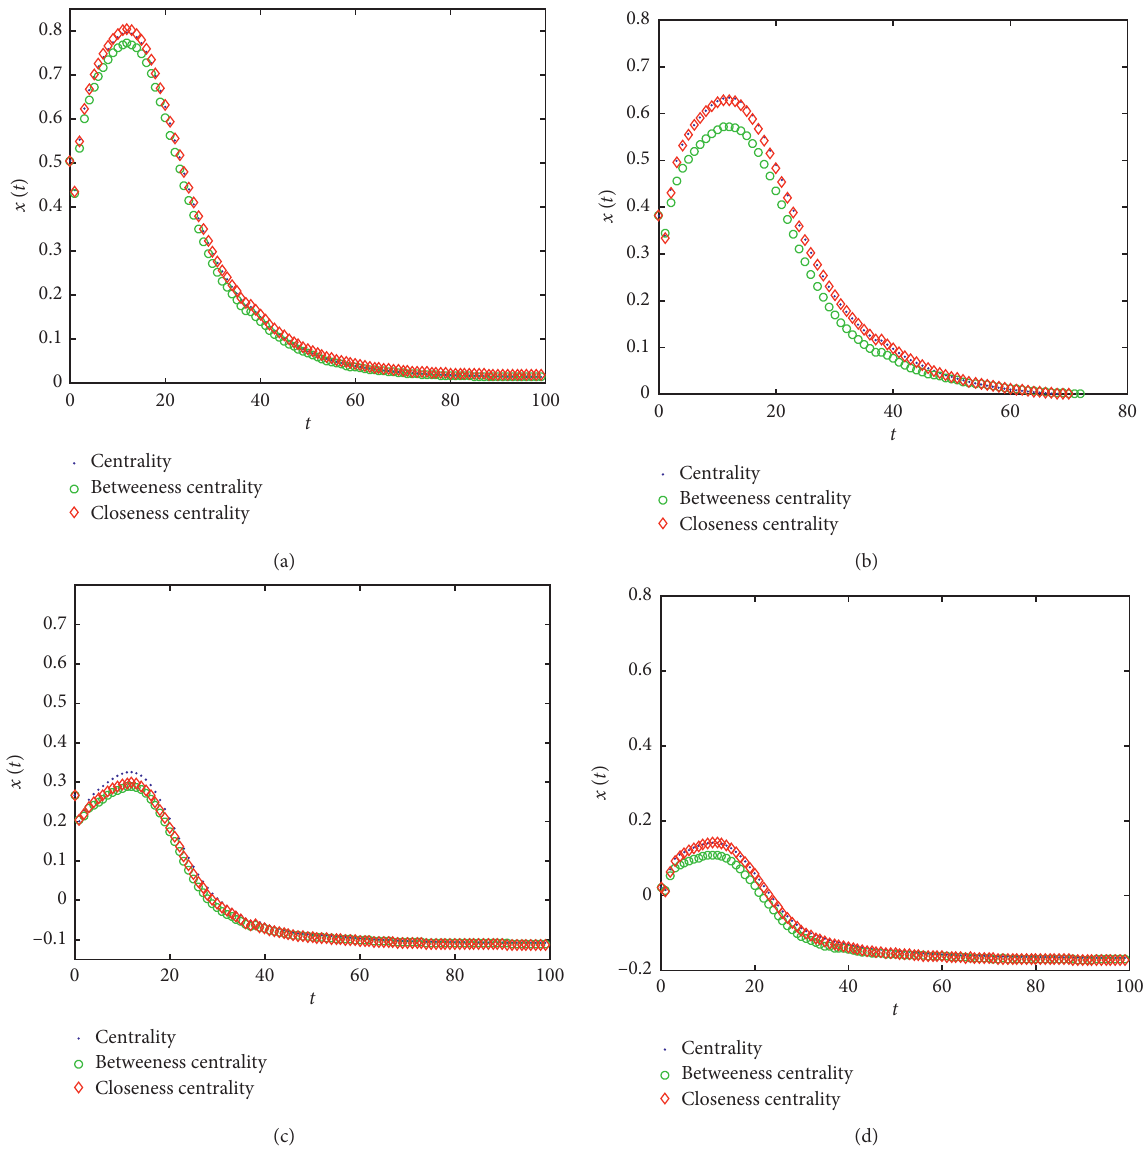
Figure 15: Evolution of average collective opinions based on three centralities: (a) supporters: 90%, opponents: 5%, and neutrals: 5%; (b) supporters: 80%, opponents:15%, and neutrals: 5%; (c) supporters: 70%, opponents: 25%, and neutrals: 5%; (d) supporters: 50%, opponents: 45%, and neutrals: